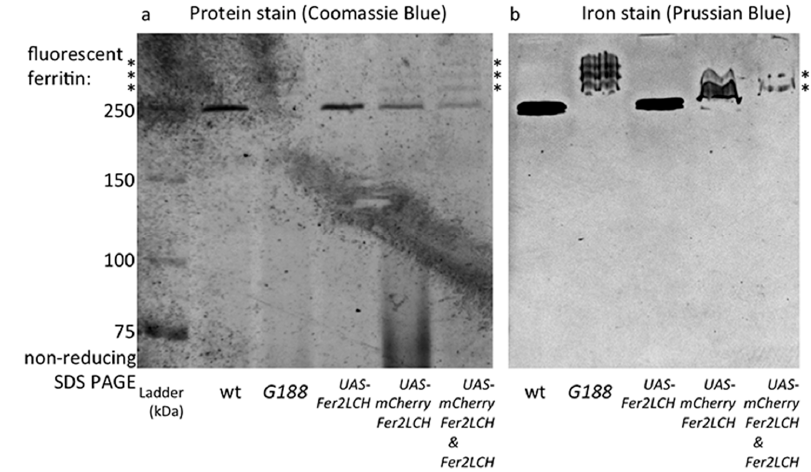
Figure 6. ( a ) Coomassie blue staining ( b ) and Prussian blue staining following non-reducing SDS PAGE of whole-fly homogenates (flies raised on 1 mM FAC) of the genotypes: wild type (wt); Fer1HCH G188/+ ; Fer2LCH 21BGal4 , UAS-Fer2LCH/+ ; Fer2LCH NP4763 , UAS-mCherry-Fer2LCH/+